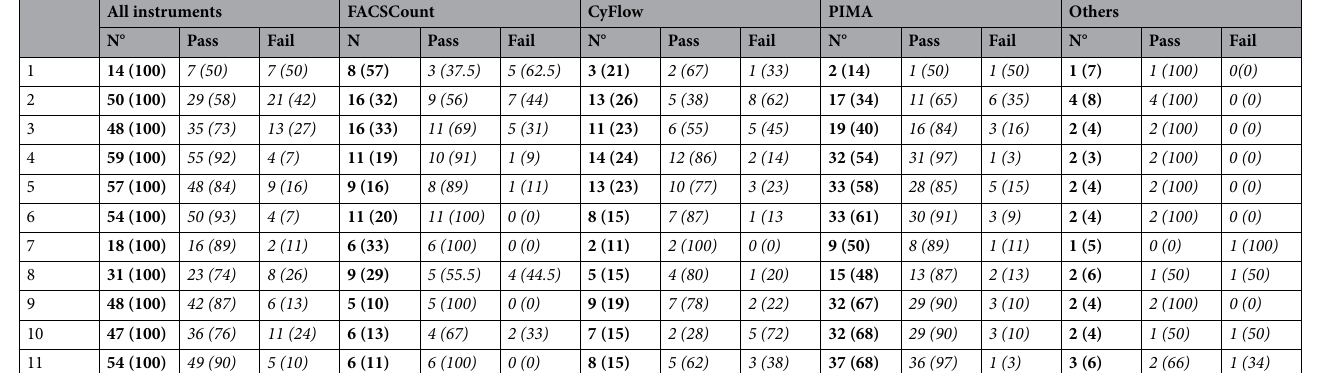
Table 1. Data on pass and failure rates for all instruments further broken down by instrument type over the 11 evaluated EQA sessions. Numbers in bold indicate absolute instrument numbers included and percentages of total in parentheses below. Numbers in italics indicate pass and fail numbers and percentages of that instrument group in parentheses.